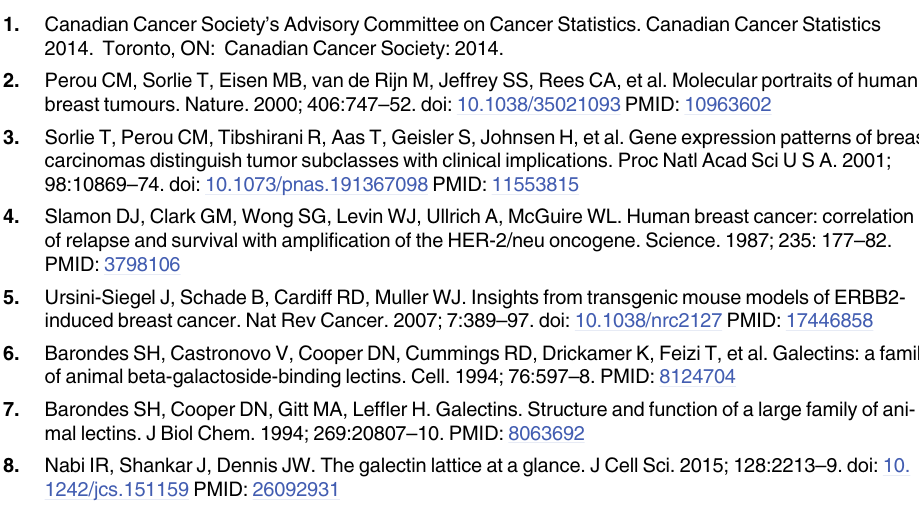
S2 Fig. mRNA upregulation of gal-7 by HER-2 in MCF-7 cells. A) mRNA levels of gal-7 and GAPDH (as a loading control) were assayed by semi-quantitative RT-PCR in MCF-7 neo and MCF-7 HER-2 cells. B) Immunohistochemical staining on smear cells to confirm HER2 gene expression.MCF-7 transfectants were a generous gift from Dr. Mien-Chie Hung (University of Texas, MD Anderson Cancer center). Scale bars, 100 μm.